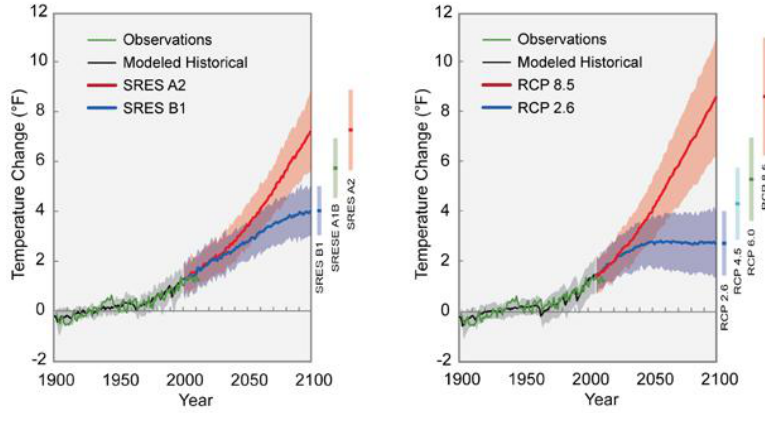
Figure 5. Emissions and temperature